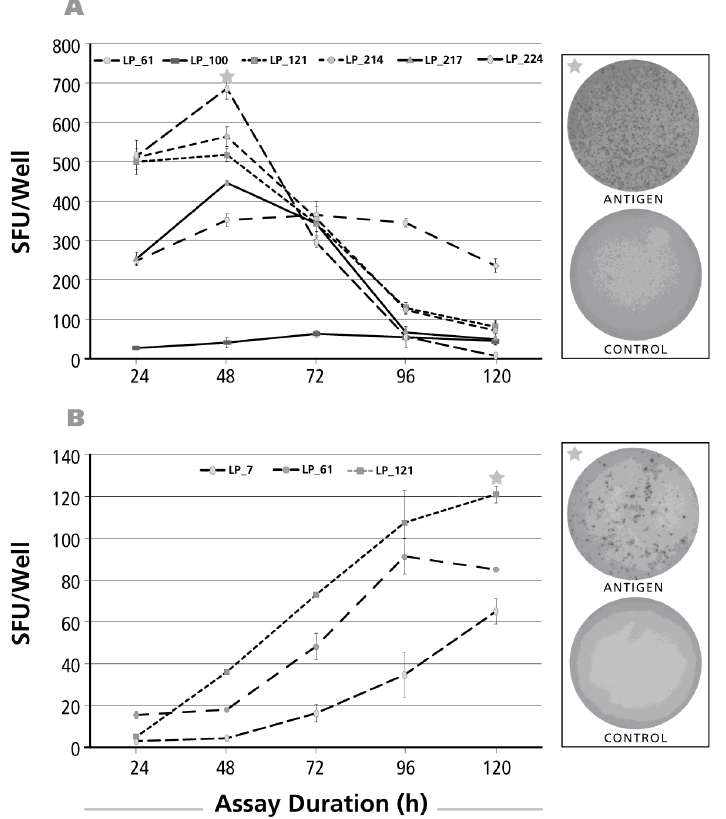
Figure 4. Kinetics of the IL-4 recall response by Th2 cells. The legend to Figure 2 applies, except that an IL-4 ELISPOT assay was done with donors and antigens that scored positive for IL-4. In Panel ( A ) CMV gr.2 was the recall antigen used to elicit IL-4 production in memory T cells; in Panel ( B ) the dust mite antigen stimulated IL-4 recall response is shown.